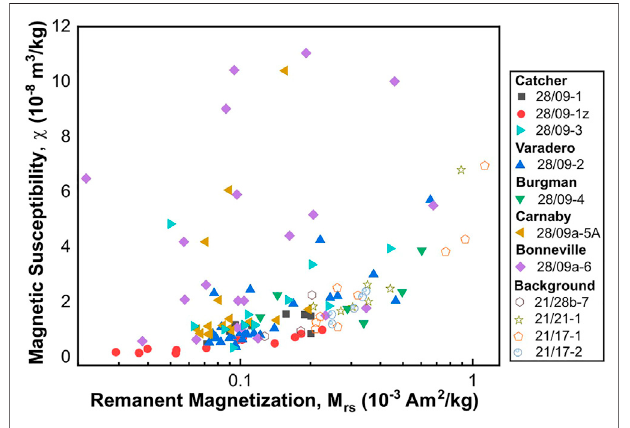
FIGURE5| Dayplotforallmeasured samples(CAD andbackground)of this study. The regions associated with the SP, SD, PSD, and MD behaviours for magnetite are shown for comparison